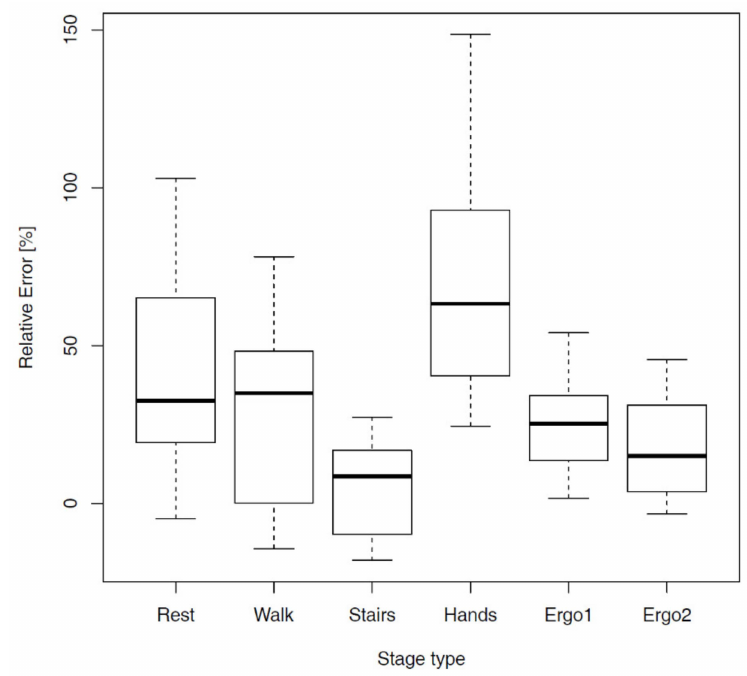
Figure 5. Graph showing calculated relative errors for each